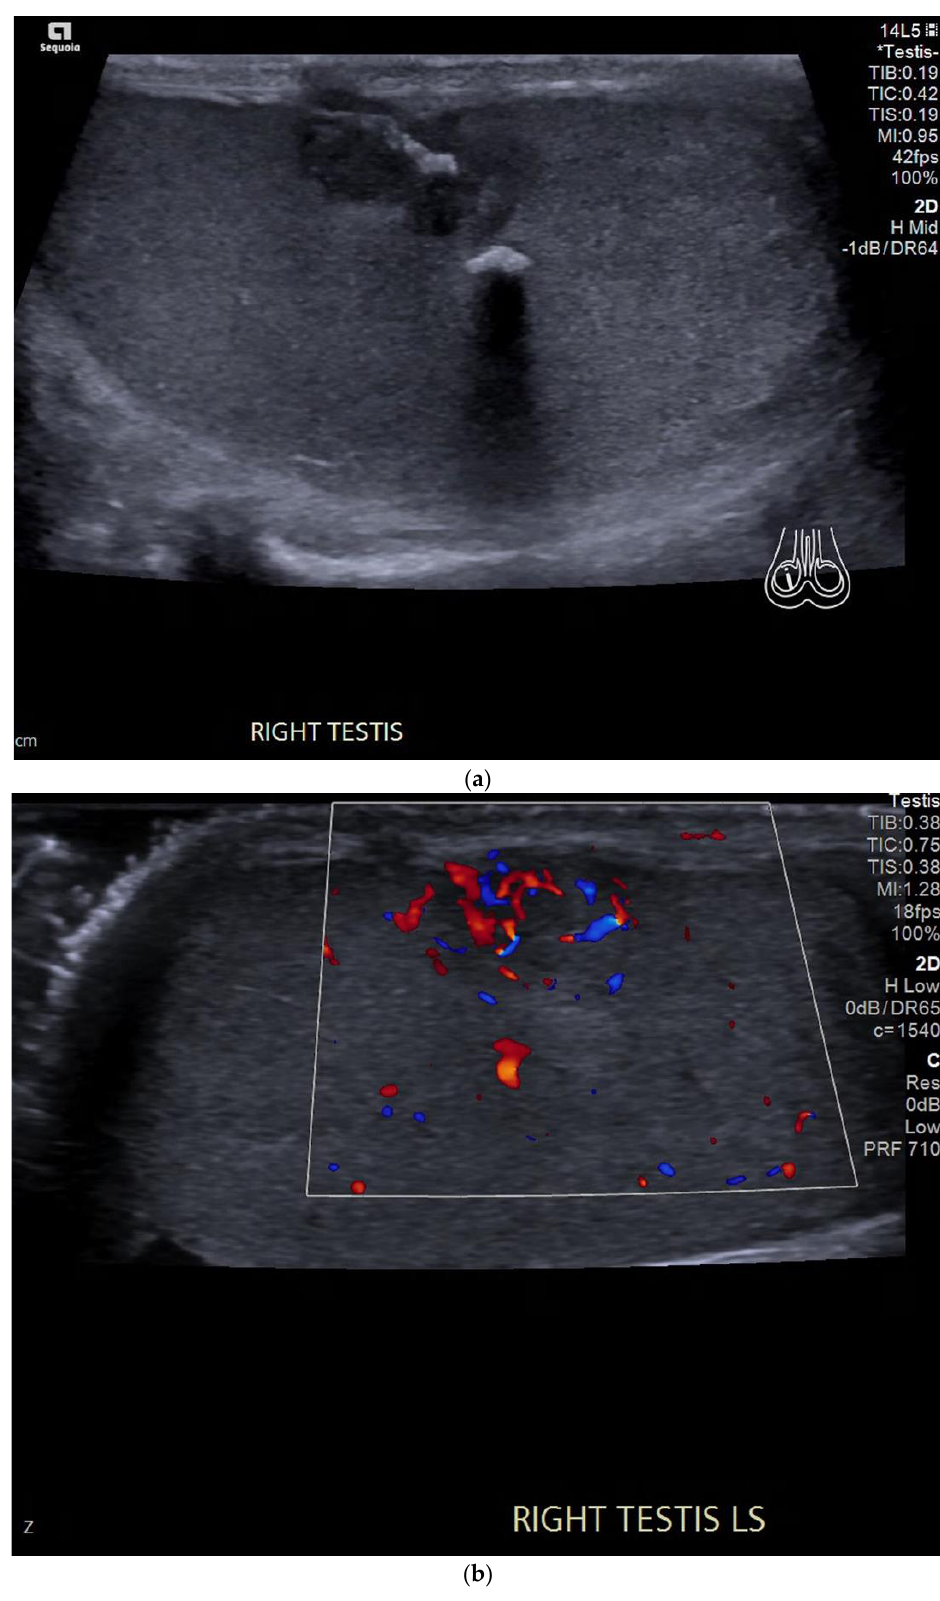
Figure 2. ( a ) B-mode ultrasound shows a heterogeneous lesion in the right testis containing macrocalcification and extending to the tunica albuginea and causing disruption of the testicular contour. ( b ) Colour Doppler ultrasound showing increased vascularity in the tumour extending to the tunica